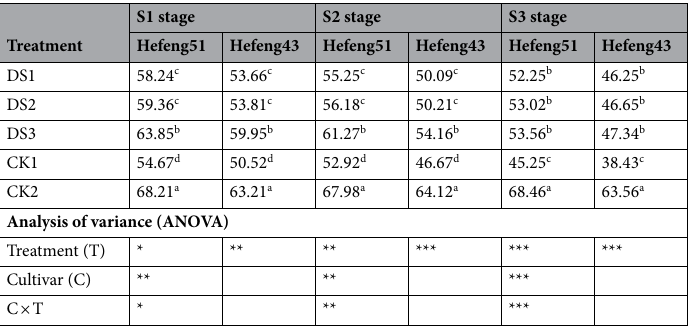
Table 2. Effects of foliar α-oxoglutarate and nitrogen on leaf RWC under drought stress (%). Means with same letter within columns are not significantly different ( P < 0.05) using LSD test. ***, **, *Significance at 0.001, 0.01, and 0.05, respectively.